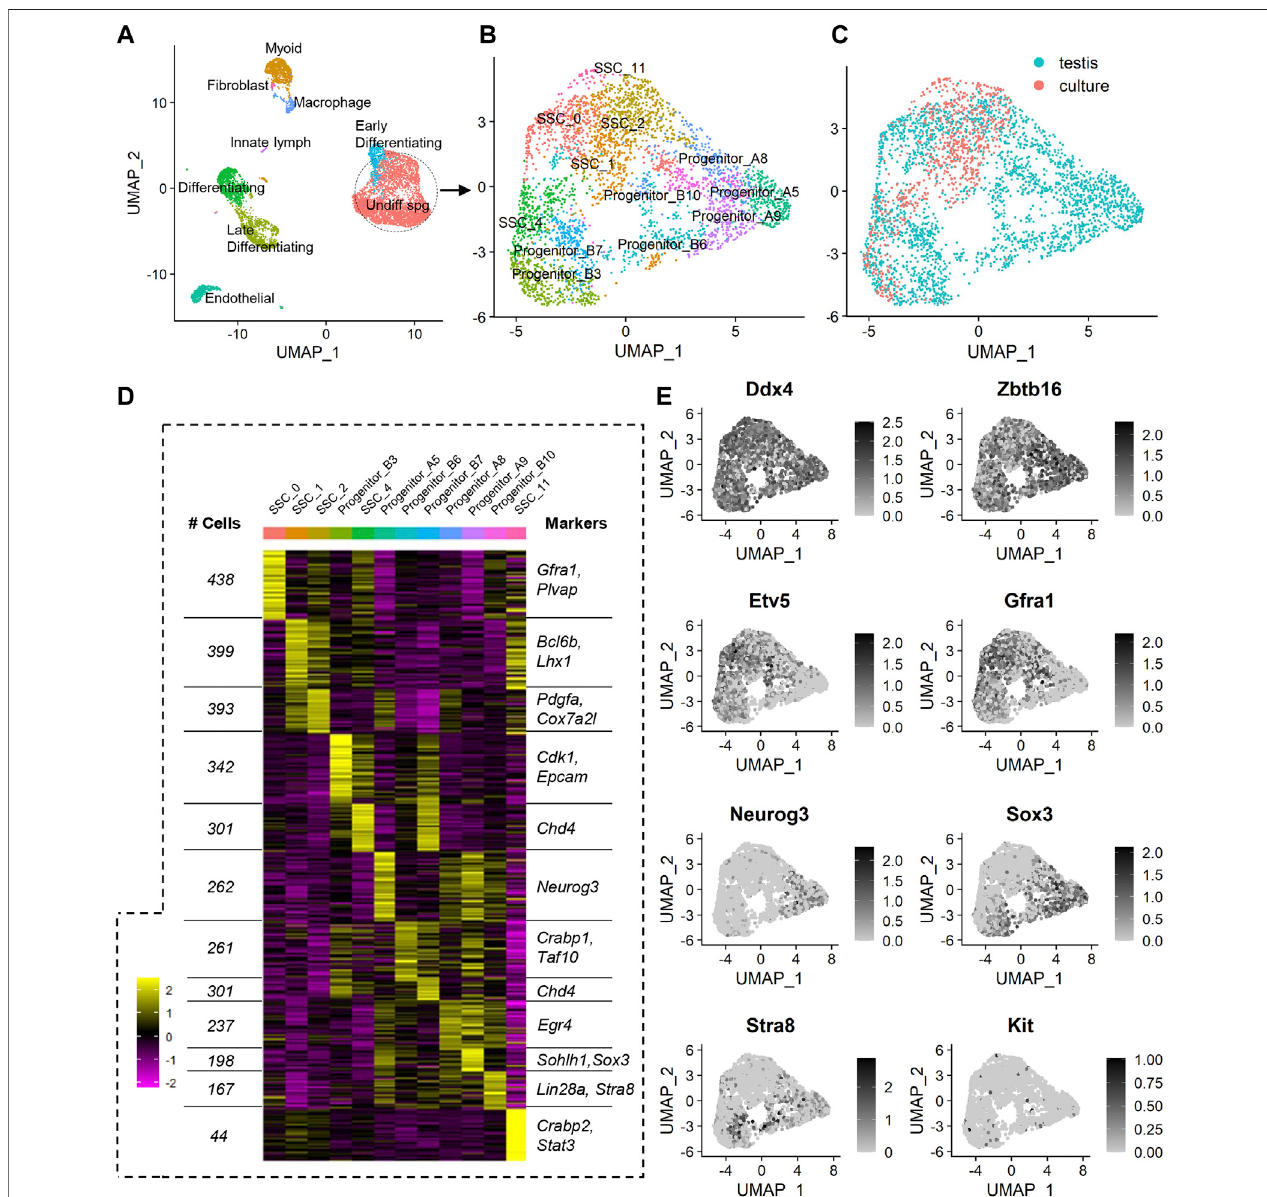
FIGURE 1 | scRNA-seq analysis of a merged dataset containing undifferentiated spermatogonia from the testis and following in vitro culture. (A) Unsupervised clustering analysis ofa merged dataset containing adult mouse testis cells (enriched for spermatogonia) and undifferentiated adult mouse spermatogonia that had been subjected to 10 weeks of in vitro culture. The dataset was projected onto UMAP plots and nine distinct cell populations were identi fi ed based on expression of known markers. (B) In order to determine the effects of in vitro culture on undifferentiated spermatogonia speci fi cally, somatic cells and later stage germ cells were excluded from downstream analyses. Re-clustering of undifferentiated spermatogonia and projection onto UMAP plots revealed 12 populations. (C) UMAP plot depictinglocalisationofcellsfromtestisandculturedatasets. (D) Heatmapshowingeffectiveclustering,thenumberofcellsineachcluster,andmarkersassociatedwith each cluster (see also Supplementary Dataset S1 ). (E) Feature plots showing expression of known markers for germ cells ( Ddx4 ), undifferentiated to early differentiating spermatogonia ( Zbtb16 ), SSCs ( Etv5 , Gfra1 ), progenitors ( Neurog3 , Sox3 ), and differentiating spermatogonia ( Kit , Stra8 ).